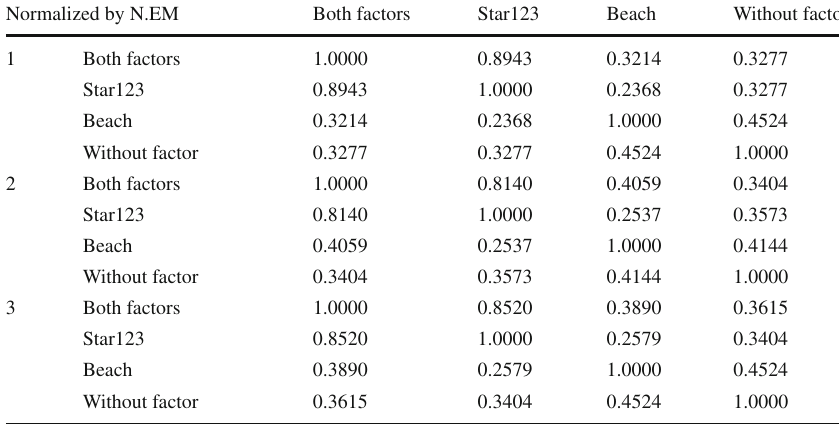
Table 6 Kendall correlations for efficiency rankings under size normalization N.EM Normalized by N.EM